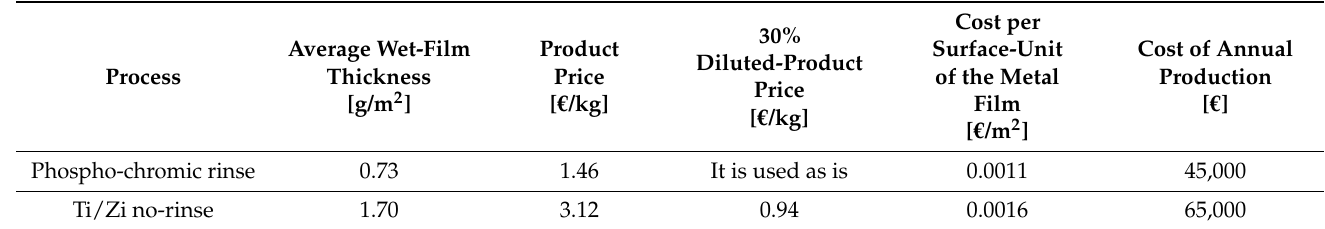
Table 5. Cost of annual-production comparison of phospho-chromic rinse and Ti/Zr no-rinse conversion-coating processes.